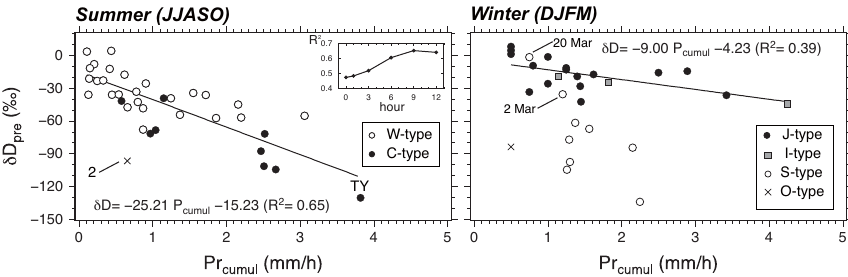
Figure 6. Relationships between δ D values in individual precipitation events and cumulative precipitation amount ( P cumul ) over 9h back trajectories of the air mass launched from the observation site in (a) summer (from June to October) and (b) winter (December to March). Symbols indicate each different precipitation type (see detail in the text). Inset: variation in the correlation coefficient ( R 2 ) for δ D- P cumul relationship with variation in the period of accumulation. The highest R 2 values were observed with 9h of cumulative precipitation in summer.